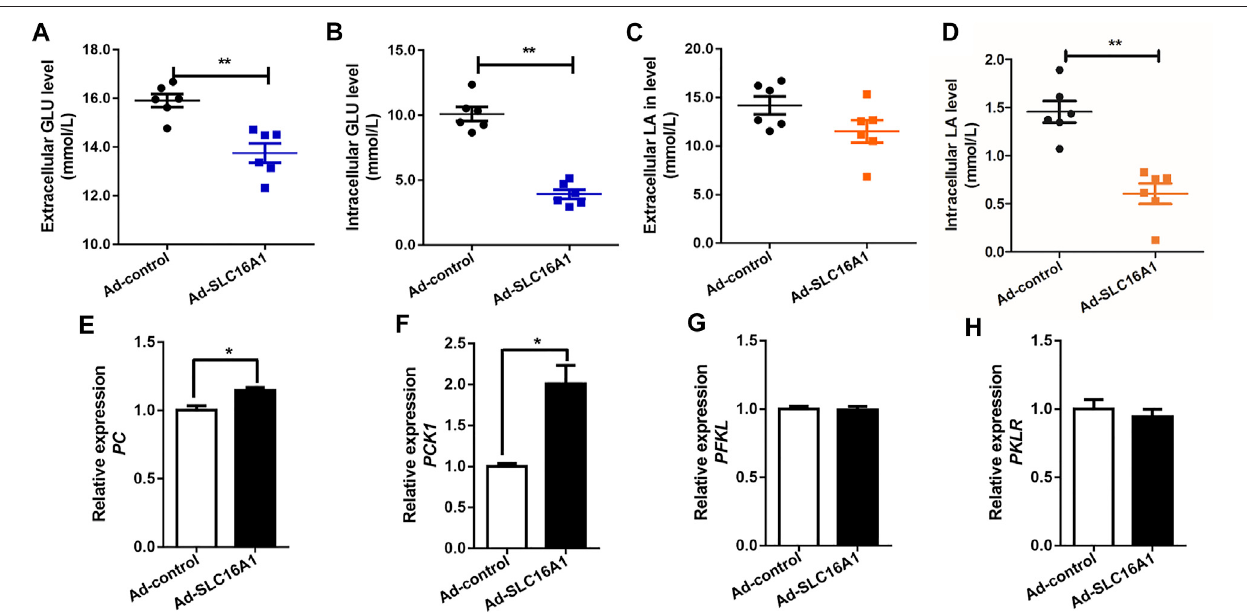
FIGURE 4 | Effect of SLC16A1 overexpressing on glucose, lactate fl ux and glucose metabolism related genes in bovine hepatocytes. (A) Extracellular and (B) intracellular GLU levels; (C) Extracellular and (D) intracellular LA levels. (G) PC , (H) PCK1 , gluconeogenesis; (E) PFKL , (F) PKLR , glycolysis. Ad-control, empty vector adenovirus; Ad- SLC16A1 , SLC16A1 recombinant vector adenovirus.